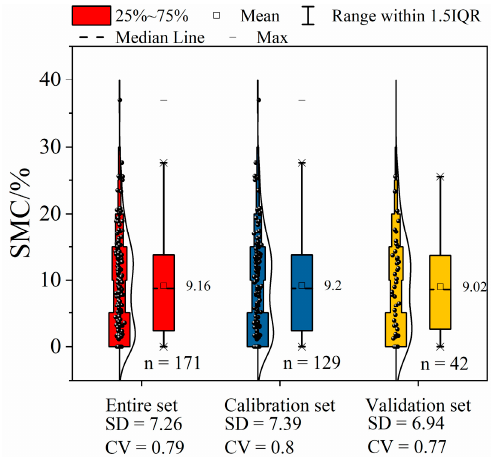
Figure 4. Statistical box diagram of soil moisture content (SMC) in different datasets.